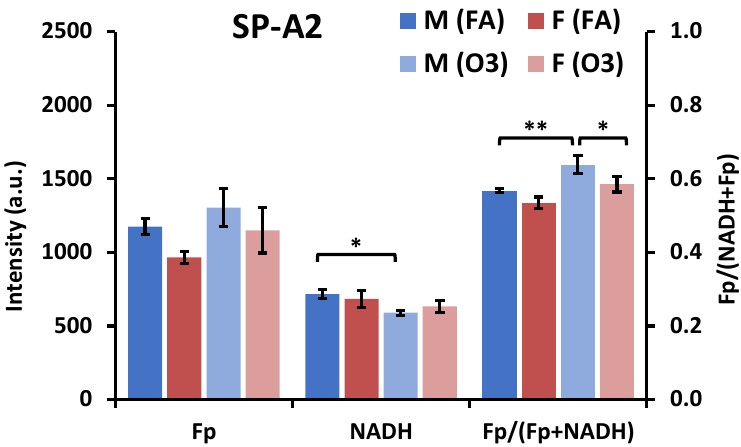
Figure 5. Sex-associated redox difference of AM in SP-A2 mice exposed to FA or O 3 (Mean ± SD). F-female; M-male. * p < 0.05, ** p < 0.01.